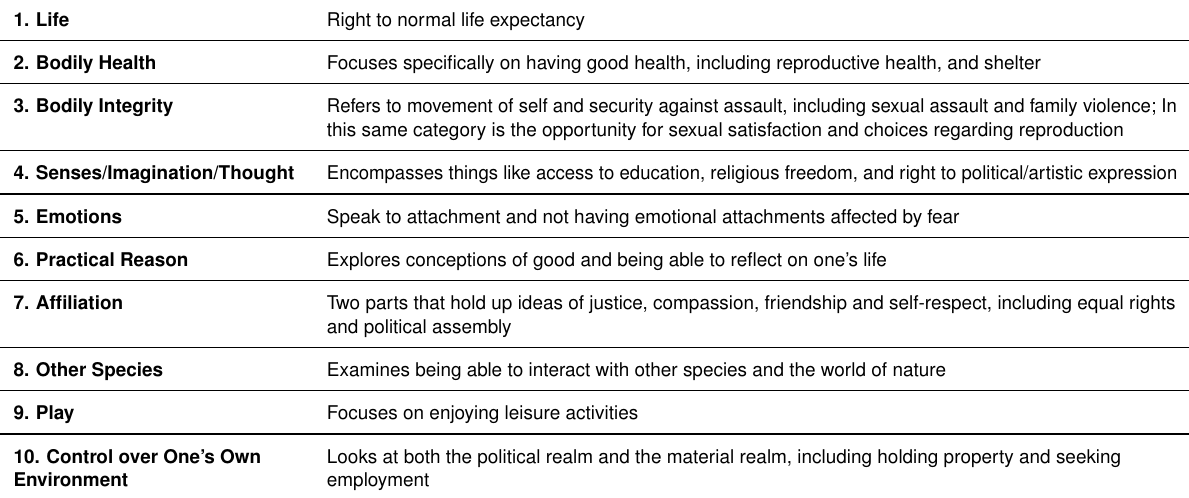
Table A1. Capabilities